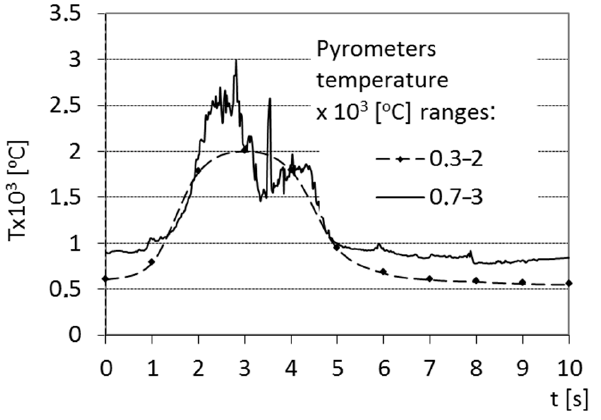
Figure 4. Temperature on the surface during the laser treatment recorded by two